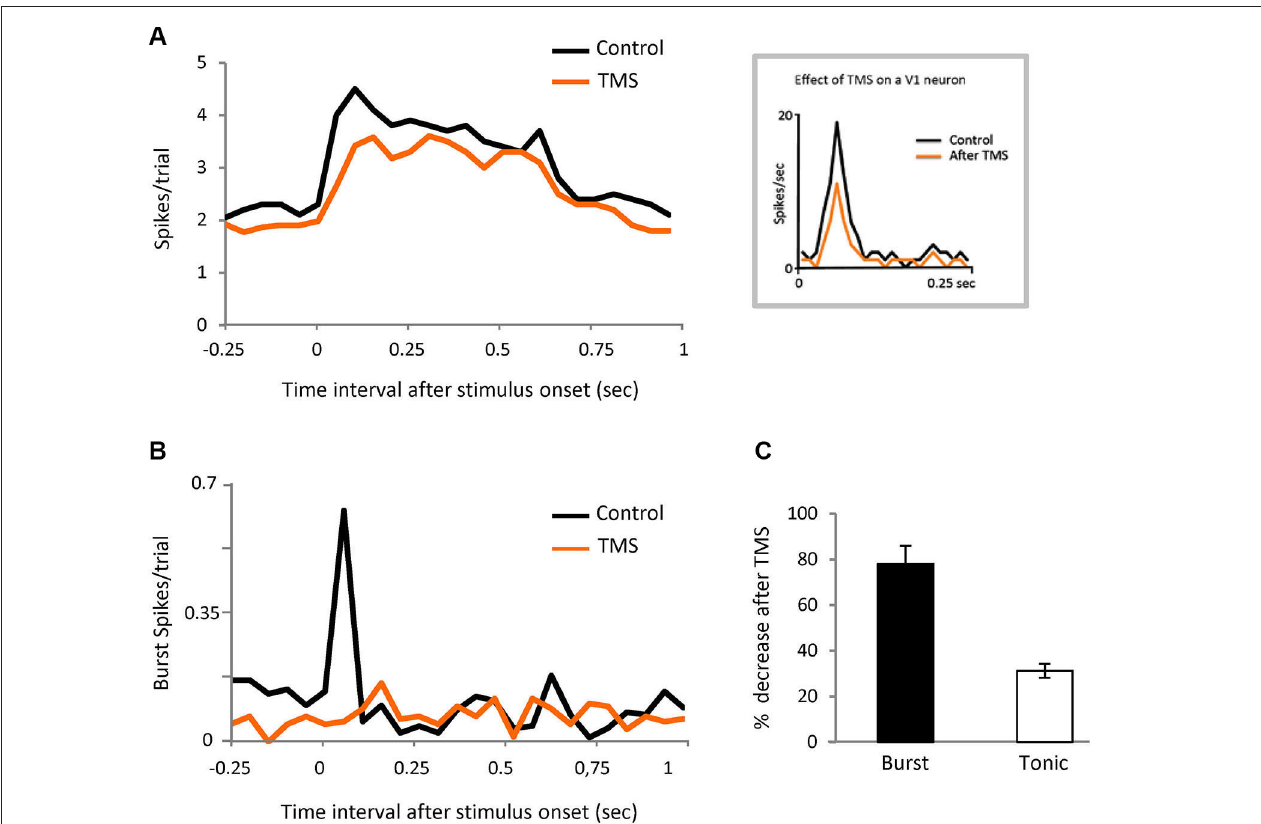
conditions. (B) PSTH showing the effect of TMS on spikes in burst for the same cells shown in panel (A). Bin size = 50 ms. (C) Comparison of the effect of TMS on spikes in burst and tonic spikes in the initial part of the response (20 to 80